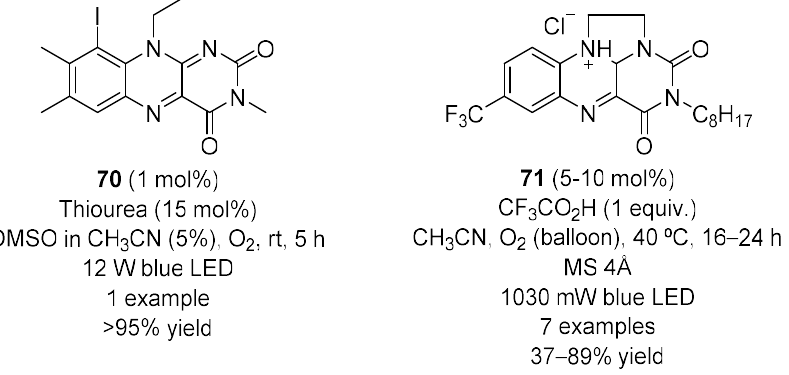
Figure 19. Results obtained in the aerobic photo-oxidation of aromatic alcohols catalyzed by 70 and 71 .